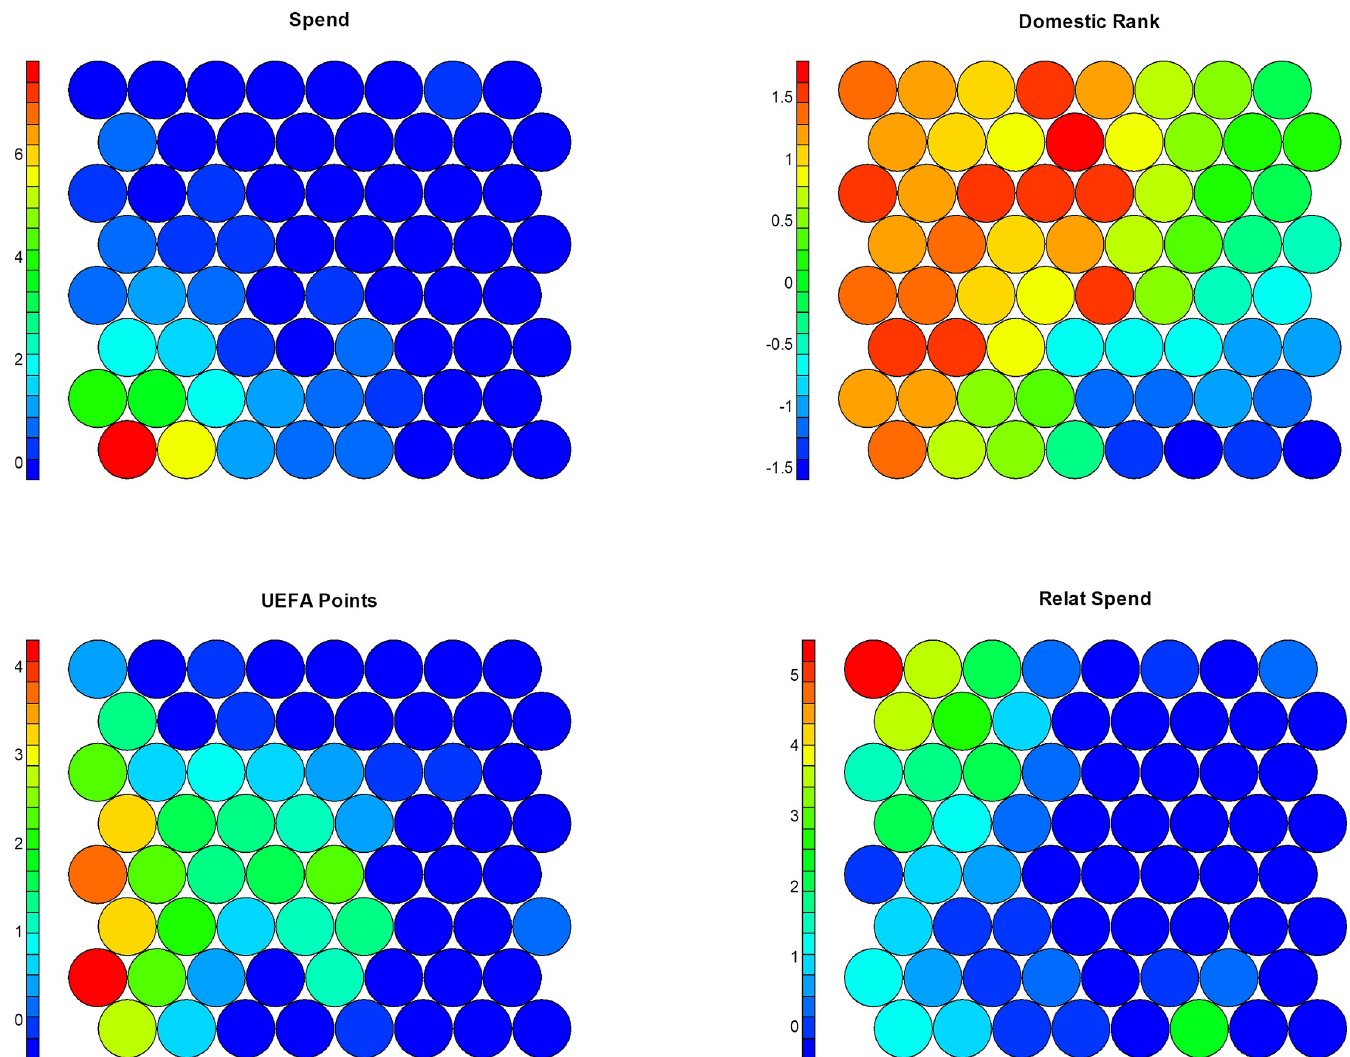
Fig 5. Kohonen SOMs for season 2001/2002. Examined variables: transfer spending ( Spend ), domestic rank ( Domestic Rank ), UEFA points ( UEFA Points ), relative transfer spending ( Relat Spend ) (all scaled). To examine the evolution of these variables, we repeated the calculations for every season. Fig 7 (upper panel) depicts the number of clubs belonging to the “blue” cluster (i.e. with high correlations between domestic rank, transfer balance, transfer spending, and UEFA points) according to their corresponding leagues. This cluster enlarges in the number of clubs and, to a lesser extent, in the number of leagues over time. We further observe that the Premier League contributes the largest number of clubs to this cluster, followed by Spain. The next most well represented first leagues are those from Germany, Portugal, Finland, Italy, France and Hun- gary. The remaining leagues are only represented by one club—except for Turkey and Nether- lands—which surprisingly are not represented at all in the blue cluster. These results suggest that variables driving this cluster have increased in their importance over time, and transfer spending is therefore gaining relevance in achieving European and domestic sportive perfor- mance. The blue cluster consists of 142 club observations during the entire time period.